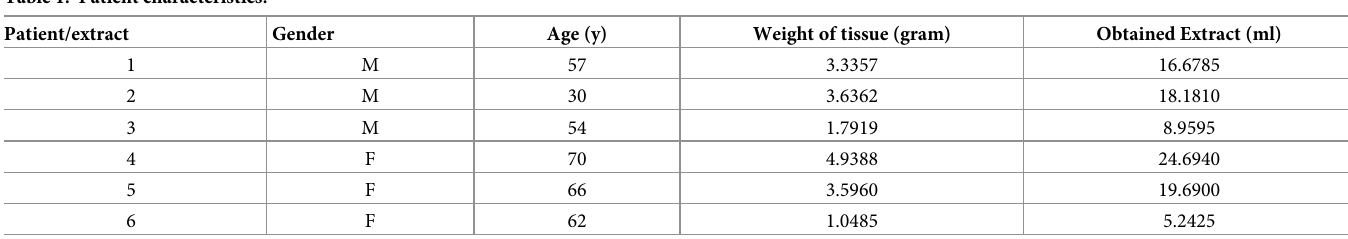
Table 1. Patient